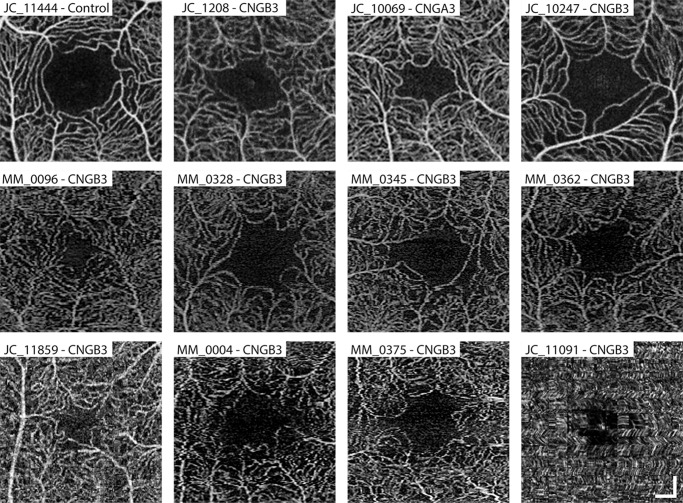
Representative OCT-A images used to subjectively decide if a FAZ is present and, if present, analyzable. An OCT-A scan from the right eye of a 26-year-old female subject with normal vision is shown for reference (top left). This normal-appearing FAZ has an area of 0.389 mm2, a circularity index of 0.593, and a roundness of 0.852. The remaining panels in the top row are examples of patients imaged using the Optovue AngioVue system with multiple frames averaged together. The second row includes single-frame images from patients imaged using the Zeiss Plex Elite 9000. All seven patients in the top two rows were determined to have a present and analyzable FAZ. The first three patients in the bottom row were all graded as having a FAZ, but distortions at the fovea make segmentation and measurement of the FAZ unreliable. The subject in the bottom right had poor image quality that made it not possible to determine whether a FAZ was present. Scale bars: 200 µm.